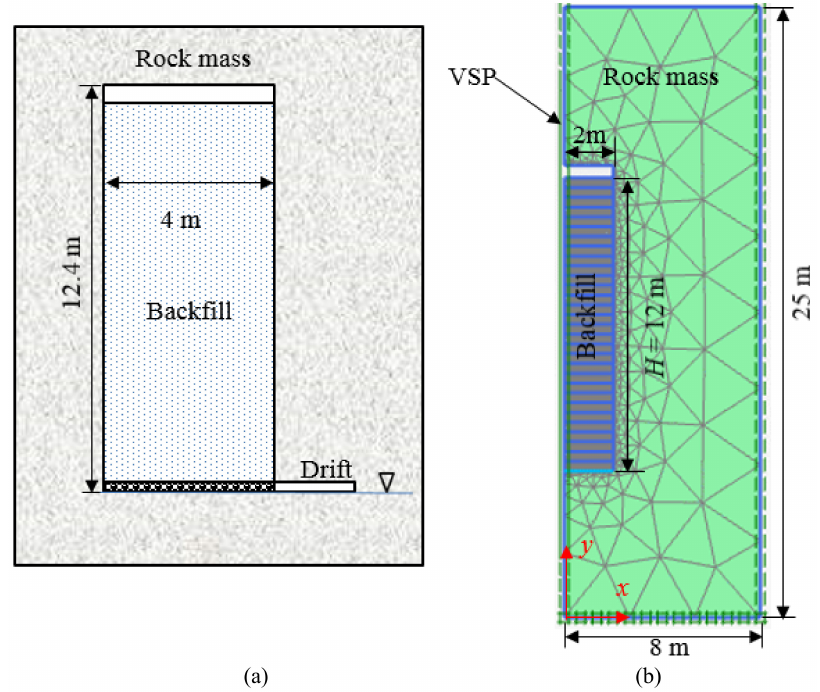
Figure 4. ( a ) The physical model and ( b ) numerical model of the backfilled stope built by Plaxis2D after considering the vertical symmetry plane (VSP). Minerals 2019 , 9 , x FOR PEER REVIEW 10 of 21